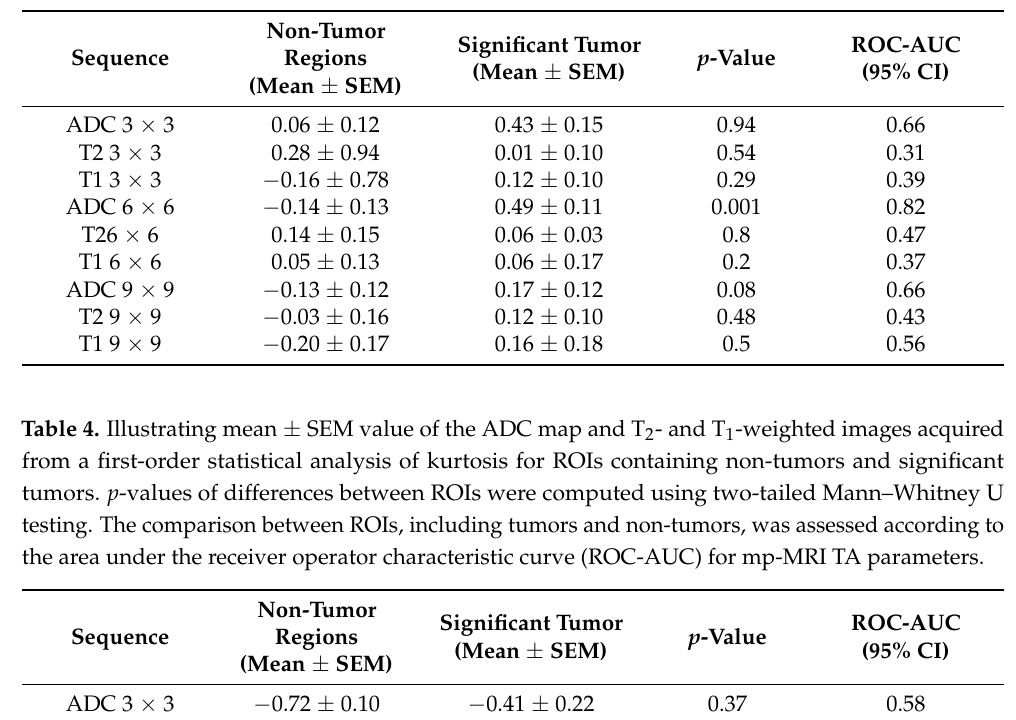
Table 3. Illustrating mean ± SEM value of the ADC map and T 2 - and T 1 -weighted images from a first-order statistical analysis of skewness for ROIs containing non-tumors and significant tumors. p -values for differences between ROIs were computed using two-tailed Mann–Whitney U testing. The comparison between ROIs, including tumors and non-tumors, was assessed according to the area under the receiver operator characteristic curve (ROC-AUC) for mp-MRI TA parameters.